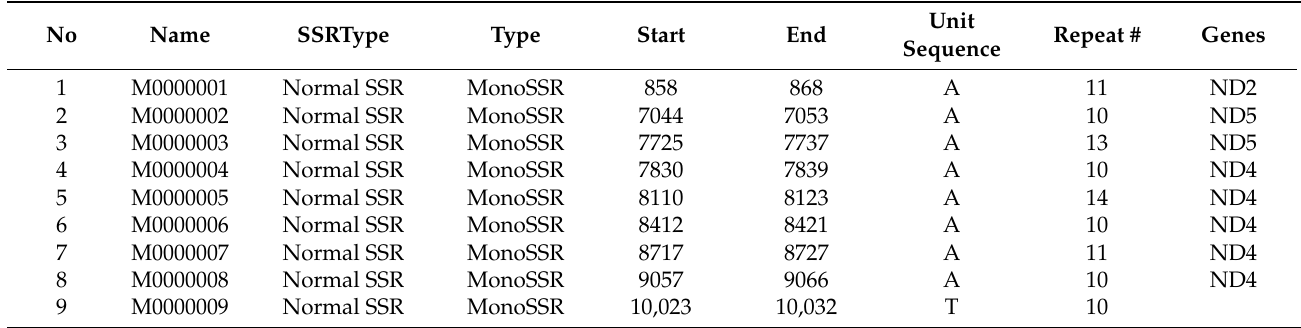
Table 2. List of simple sequence repeats (SSRs) identified from a new WBPH mitogenome collected in Korea.